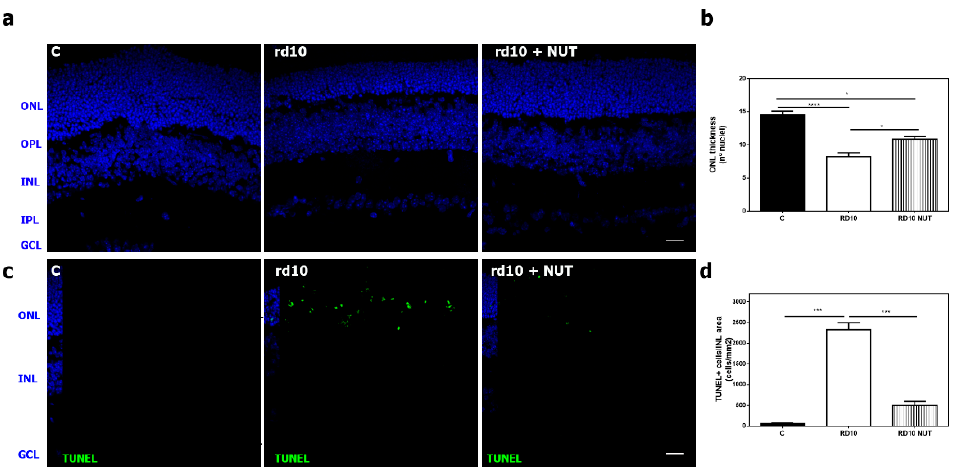
Figure 2. Effect of oral administration of nutraceuticals on retinal degeneration in rd10 retinas at PD18: ( a , b ) representative photomicrographs of retinal sections showing DAPI staining and ( b ) quantification of number of rows of nuclei in the ONL in control mice (C), untreated rd10 mice and NUT-treated rd10 mice; ( c , d ) representative photomicrographs of retinal sections showing TUNEL-stained and DAPI-counterstained sections and ( d ) quantification of the number of TUNEL-positive nuclei cells in control mice (C), untreated rd10 mice and NUT-treated rd10 mice. rd10 mice were treated with NUT from PD9 to PD18. Scale bar: 20 µm. ONL: outer nuclear layer; OPL: outer plexiform layer; INL: inner nuclear layer; IPL: inner plexiform layer; GCL: ganglion cell layer. Kruskal–Wallis test and post hoc Dunn’s multiple comparisons test, * p < 0.05; *** p < 0.001; **** p < 0.0001. Data were presented as mean ± standard error of the mean (SEM). Eight–ten mice were used for each group.